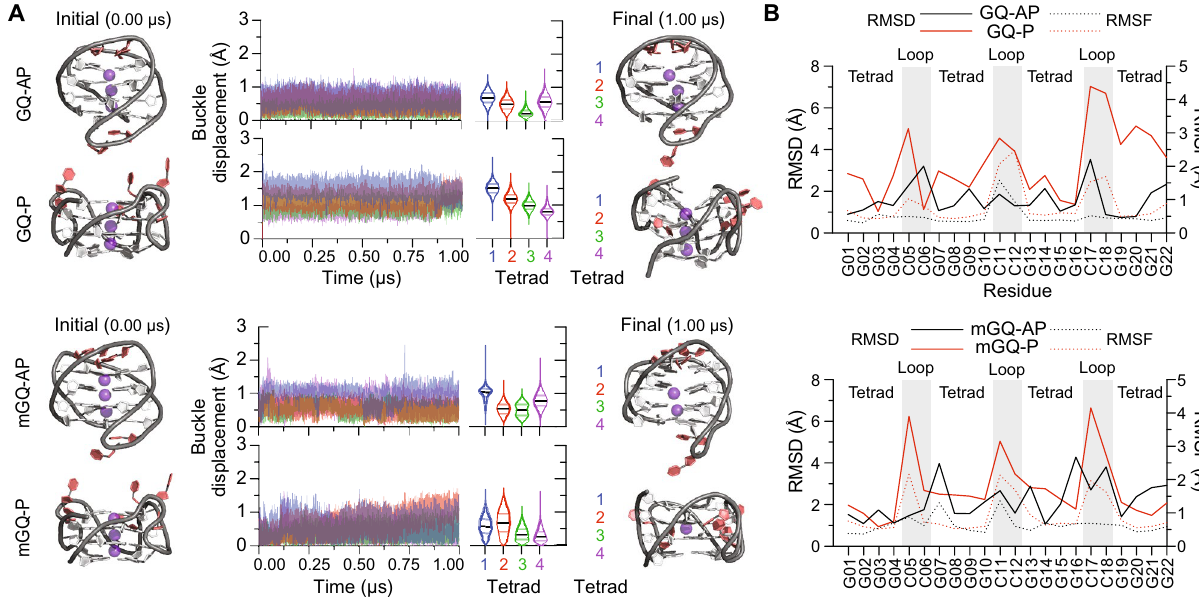
Figure 3. Nonmethylated and methylated DNA GQ structures formed by the C9-NRE are stable in MD simulations. ( A ) The buckle displacement values for each tetrad of the nonmethylated (top; GQ-AP, GQ-P) and methylated (bottom; mGQ-AP, mGQ-P) GQ are plotted over the 1 µs MD simulation time course. The frequency distribution of buckle displacement data, located to the right of the plotted buckle displacement time course, are shown as violin plots with solid lines denoting the mean and dotted lines the quartiles. The respective initial (0 µs) and final (1 µs) MD simulation representative GQ atomic structures are shown on the left and right of the buckle displacements graphs, respectively. ( B ) The mean RMSD (left y -axis, solid lines) and RMSF (right y -axis, dashed lines) analyses are plotted per residue for nonmethylated (top; GQ-AP, GQ-P) and methylated (bottom; mGQ-AP, mGQ-P). Individual residues are labeled from 5 ′ to 3 ′ below the x -axis with ‘G’ and ‘C’ representing guanine and cytosine residues, respectively. Residues that are part of tetrads versus loops (gray strips) are designated at the top of the